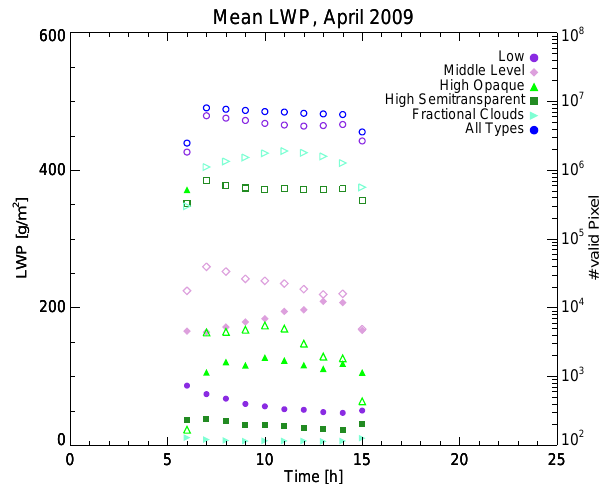
Fig. 8. Filled symbols: average intrinsic diurnal cycle of LWP for distinct cloud types in the cloud deck off the coast of Namibia and Angola, April 2009; corresponding open symbols: respective num- ber of